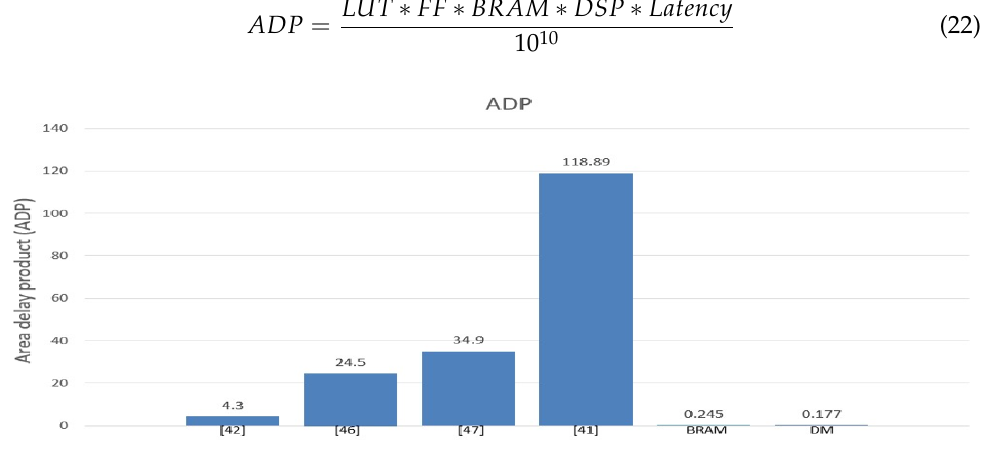
Figure 12. Area-Delay Product.